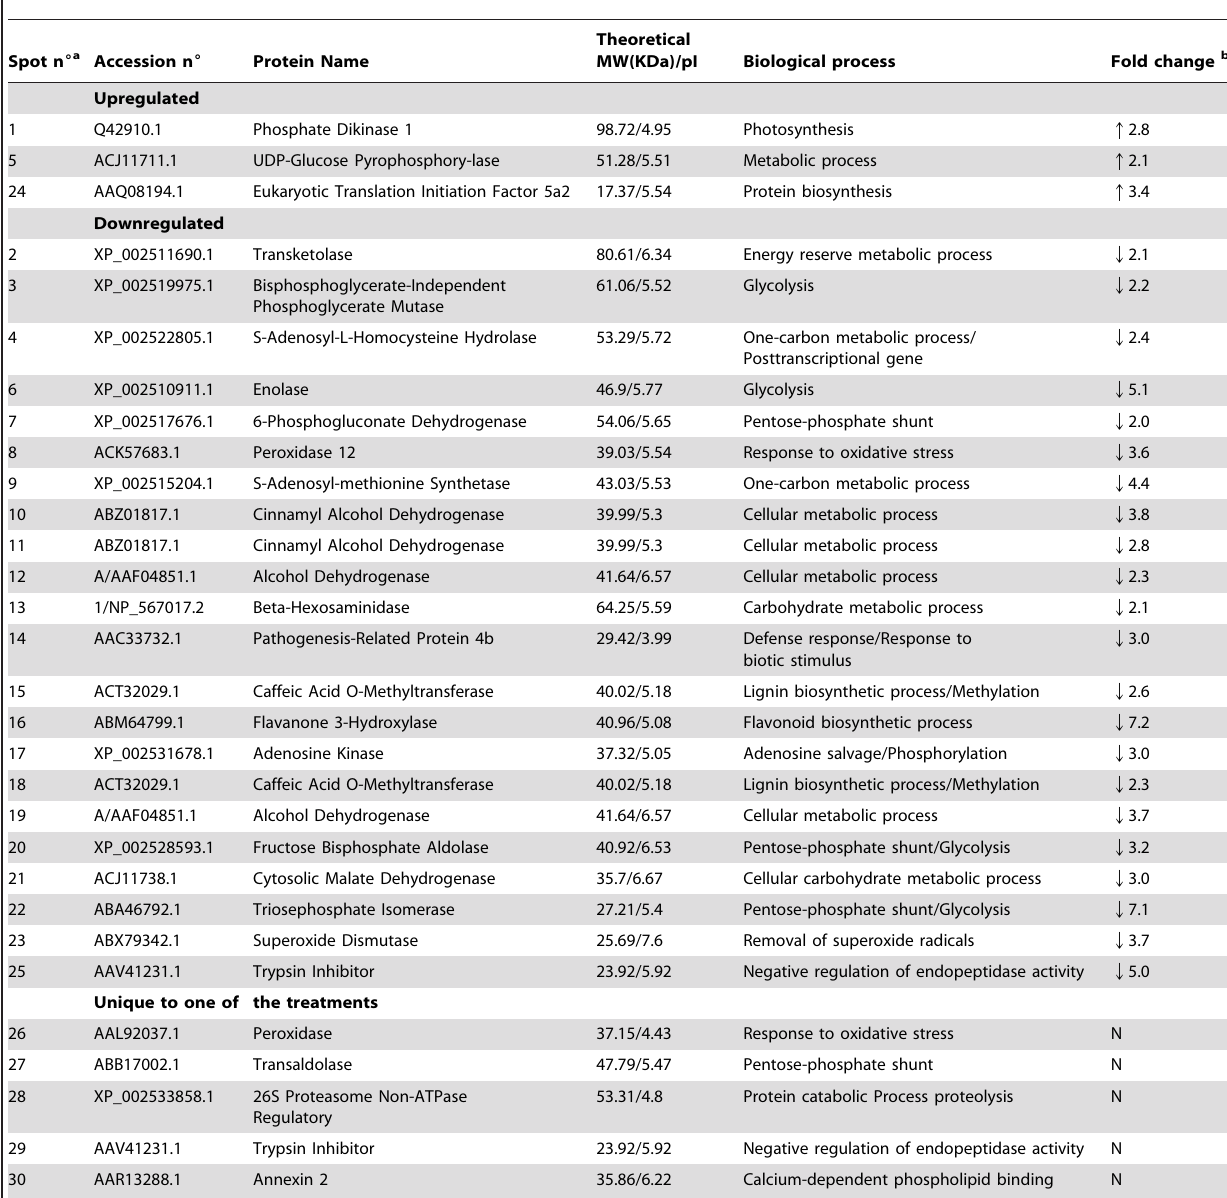
Table 3. Proteins from roots of the TSH-774 genotype of Theobroma cacao identified by mass spectrometry.